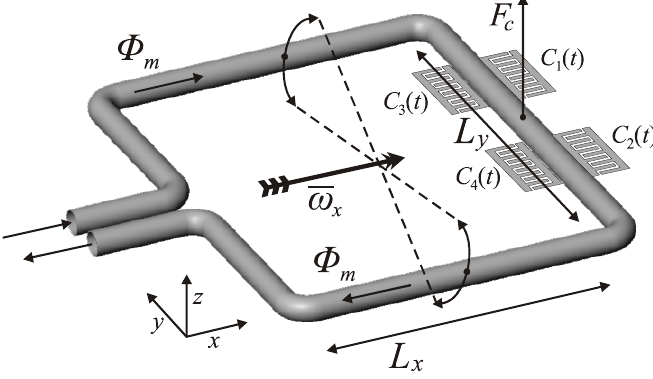
Figure 3. Coriolis flow sensor.